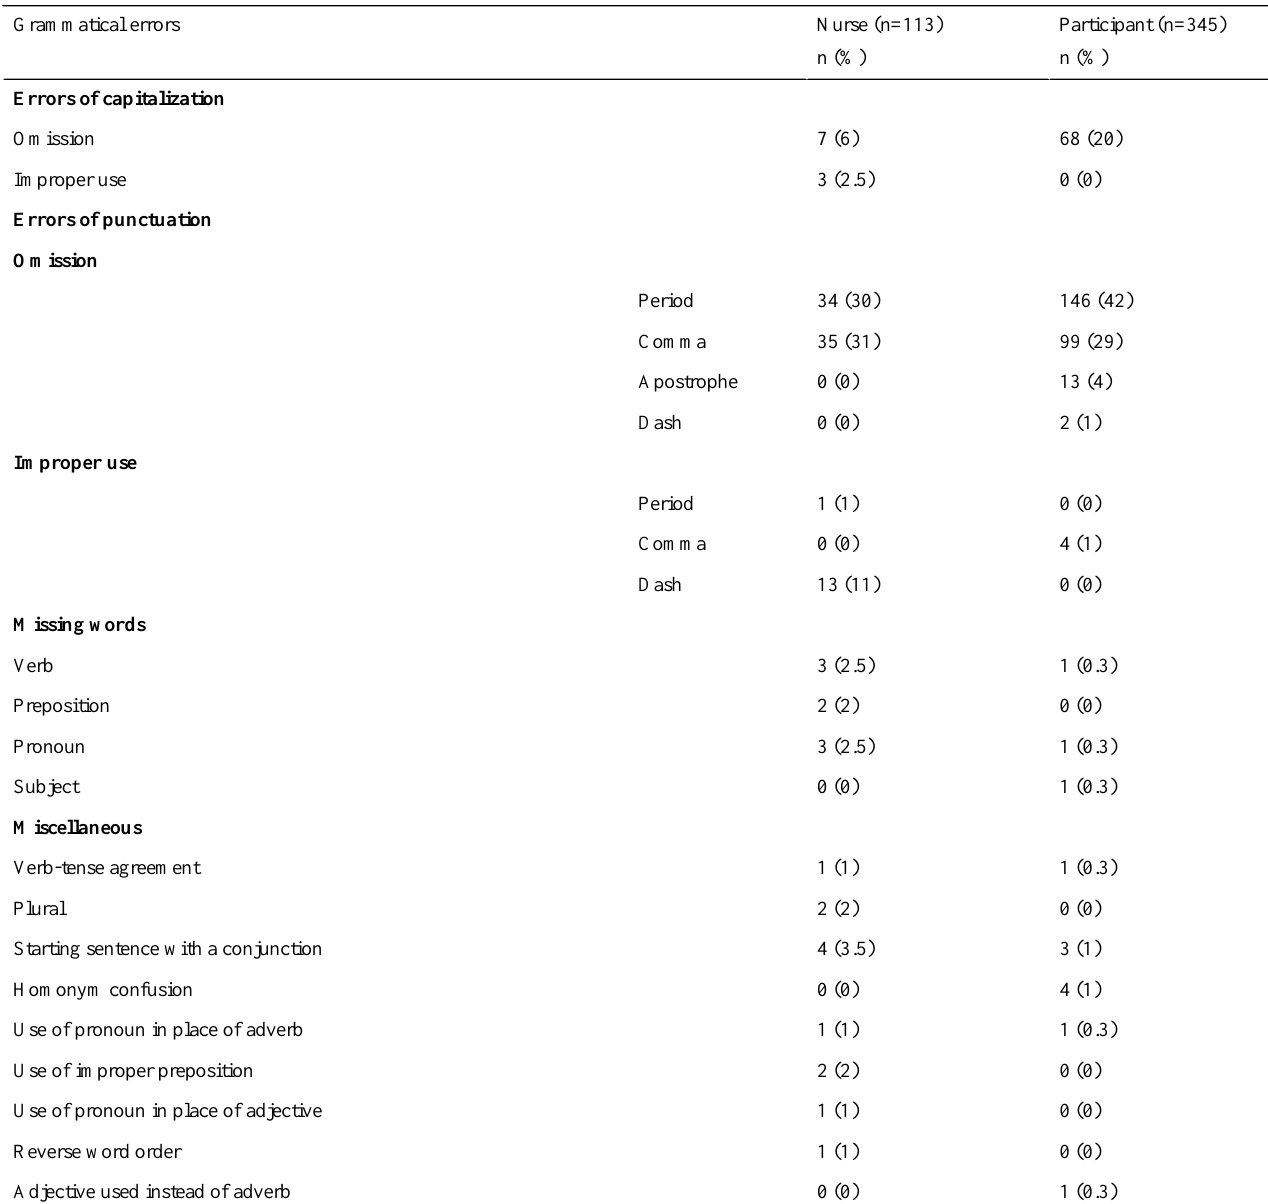
Table 3. Presence of grammatical errors by both researchers and